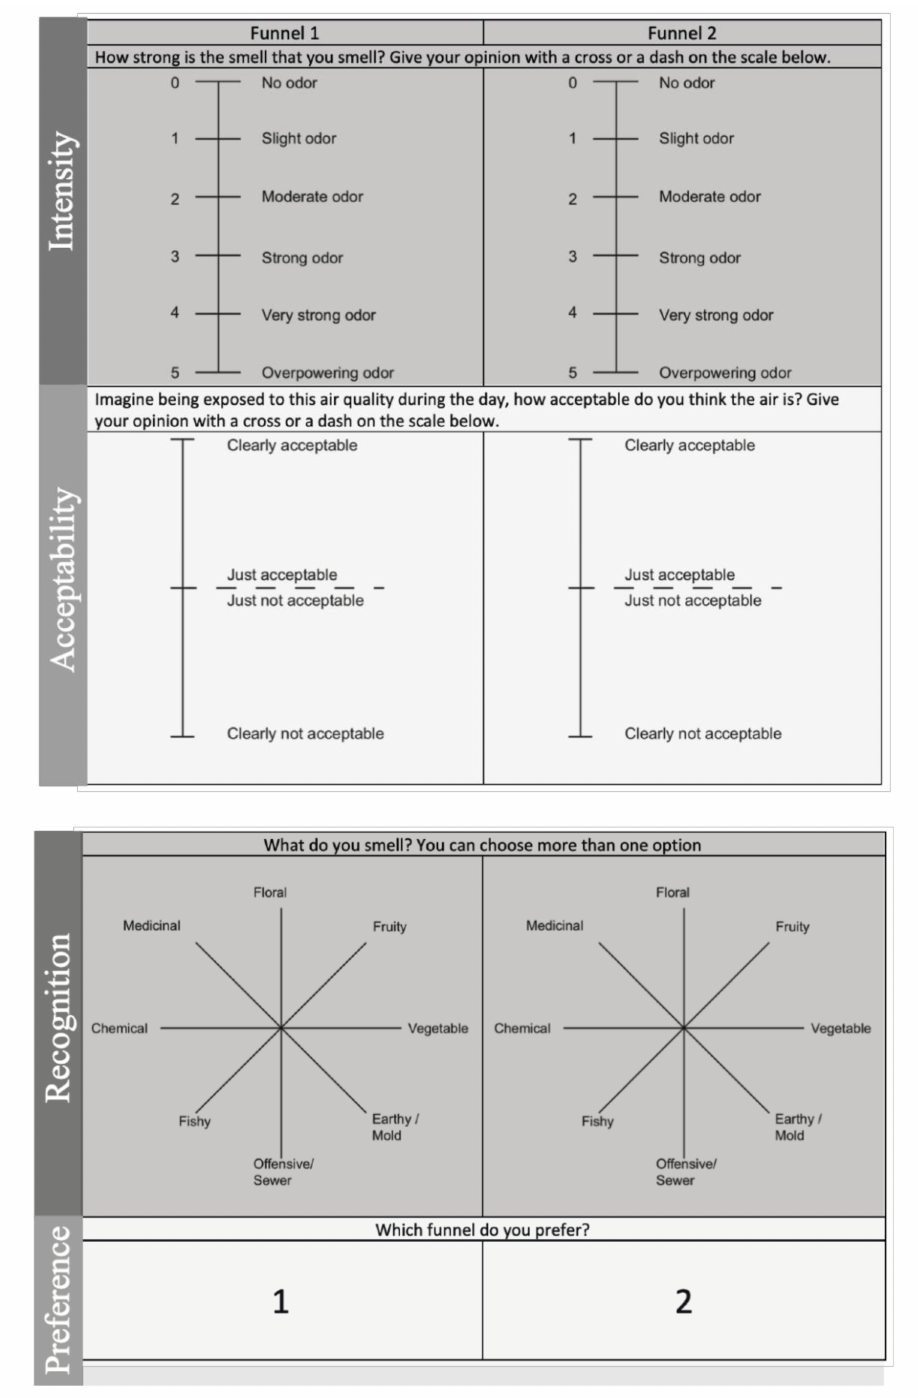
Figure 4. Questionnaire: intensity, acceptability, odor recognition, and preference